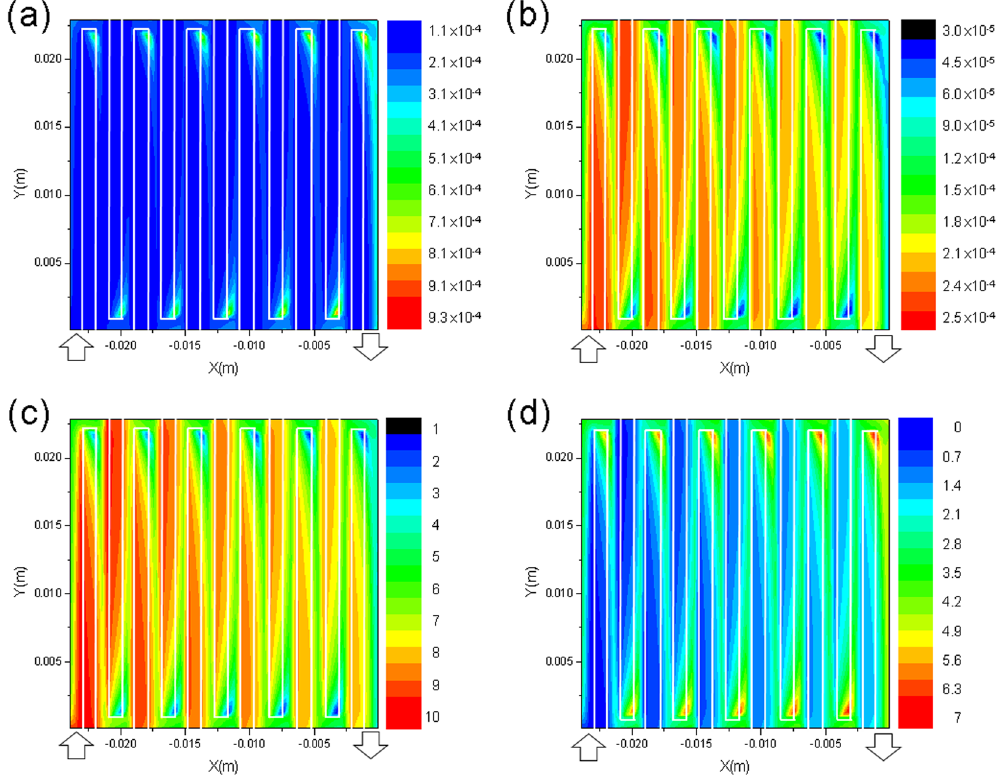
Figure 5. Simulated 2D concentration contour plots (in mole/m 3 ) of four active species: ( a ) holes, ( b ) electrons, ( c ) VO 2 + , and ( d ) VO 2 + , along the midplane of the photoelectrode under a photocurrent of 0.5 mA and electrolyte flow rate of 0.01